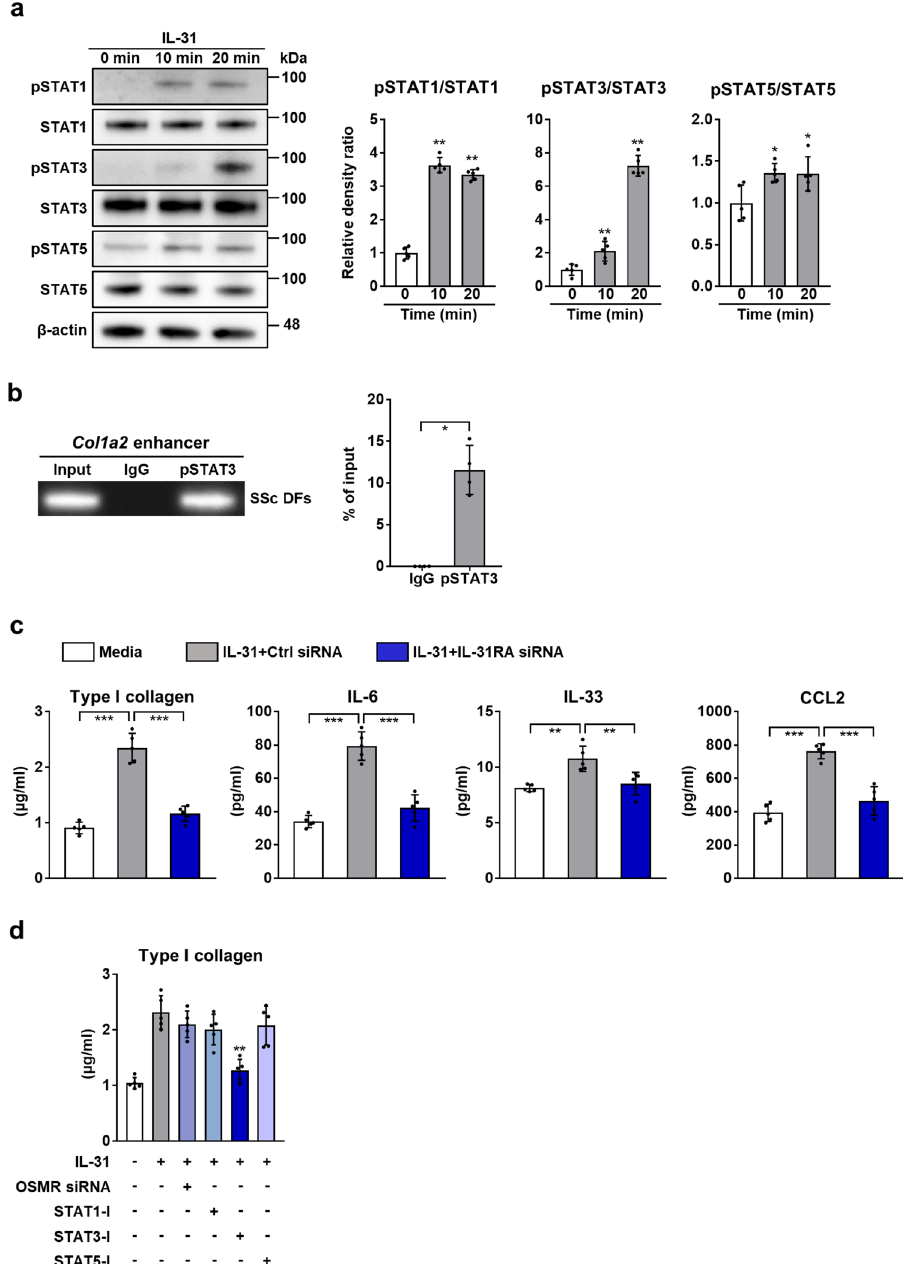
Fig. 4 IL-31 exerted its effects through IL-31RA and STAT3. a Representative western blot analysis of STAT1, STAT3, STAT5 and their phosphorylated forms in dcSSc DFs treated with rhIL-31 (50 ng/ml; left). Quanti fi cation of protein expression normalized to β -actin (right). Exact p values (10 min vs. 0 min, 20 min vs. 0 min) = 0.008, 0.008 (pSTAT1/STAT1); 0.008, 0.008 (pSTAT3/STAT3); 0.016, 0.040 (pSTAT5/STAT5). Relative fold differences (10 min, 20 min) = 3.63, 3.34 (pSTAT1/STAT1); 2.11, 7.23 (pSTAT3/STAT3); 1.36, 1.35 (pSTAT5/STAT5). b Representative ChIP assay on dcSSc DFs assessing the binding of phosphorylated STAT3 to the Col1a2 enhancer (left). Immunoprecipitated chromatin was analyzed by real-time PCR using speci fi c primers for the HS4 region of the Col1a2 enhancer (right). Exact p value = 0.029. n = 4 biologically independent experiments. c Protein levels of type I collagen, IL-6, IL-33, and CCL2 were evaluated by ELISA in the supernatants of dcSSc DFs that were transfected with IL-31RA siRNA and treated with rhIL- 31 (50 ng/ml). Exact p values (media vs. IL-31 + Ctrl siRNA, media vs. IL-31 + IL-31RA siRNA, IL-31 + Ctrl siRNA vs. IL-31 + IL-31RA siRNA) = 0.00000009, 0.111, 0.0000008 (Type I collagen); 0.0000009, 0.202, 0.000007 (IL-6); 0.002, 0.766, 0.005 (IL-33); 0.000003, 0.222, 0.00002 (CCL2). d Protein levels of Type I collagen were measured by ELISA in the supernatants of dcSSc DFs that were transfected with OSMR siRNA or treated with inhibitors for STAT1 (STAT1-I: Fludarabine; 50 µ M), STAT3 (STAT-I: Stattic; 5 µ M), or STAT5 (STAT5-I: CAS 285986-31-4; 50 µ M), followed by the treatment with rhIL-31 (50 ng/ml). Exact p values = 0.238 (IL-31 + OSMR siRNA vs. IL-31), 0.175 (IL-31 + STAT1-I vs. IL-31), 0.008 (IL-31 + STAT3-I vs. IL-31), 0.548 (IL-31 + STAT5-I vs. IL-31). n = 5 biologically independent experiments, unless otherwise noted. Data are presented as mean ± SD. * p < 0.05, ** p < 0.01, and *** p < 0.001. Signi fi cance was determined using two-tailed Mann-Whitney U test ( a , b , and d) and one-way analysis of variance followed by Tukey ’ s post hoc comparison test ( c ). pSTAT1, phosphorylated STAT1; pSTAT3, phosphorylated STAT3; pSTAT5, phosphorylated STAT5. Source data are provided as a Source Data fi